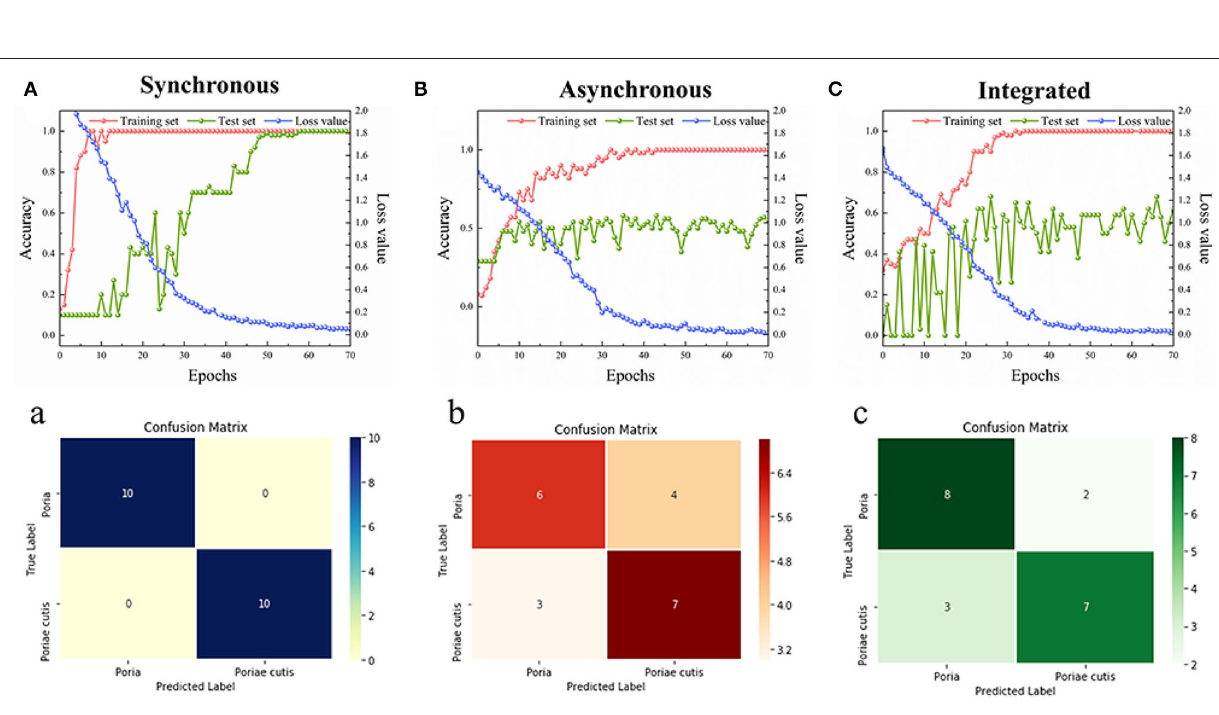
Frontiers in Microbiology |